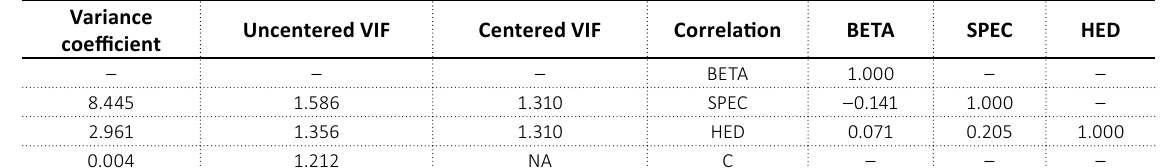
Table 2. The results of multicollinearity analysis